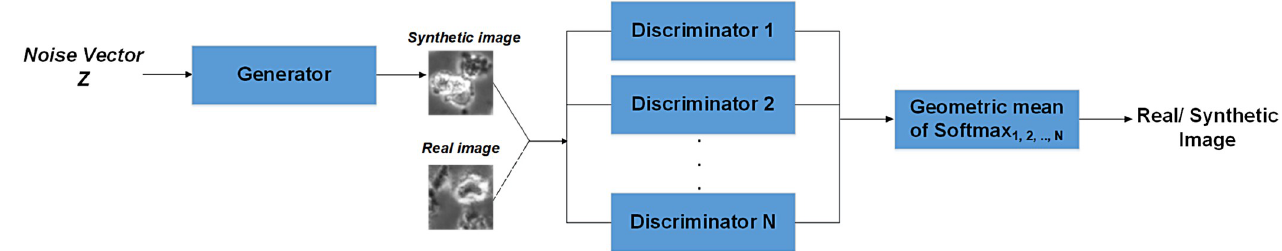
Fig 10. Architecture of GMAN. The generator is trained to take as input a random noise vector and generate an image that resembles the training data. The task of the N discriminators are to predict if the input image to the discriminator is either a real or a synthetic image. In our architecture of GMAN the softmax outputs of the N discriminators are combined together by computing their geometric mean.